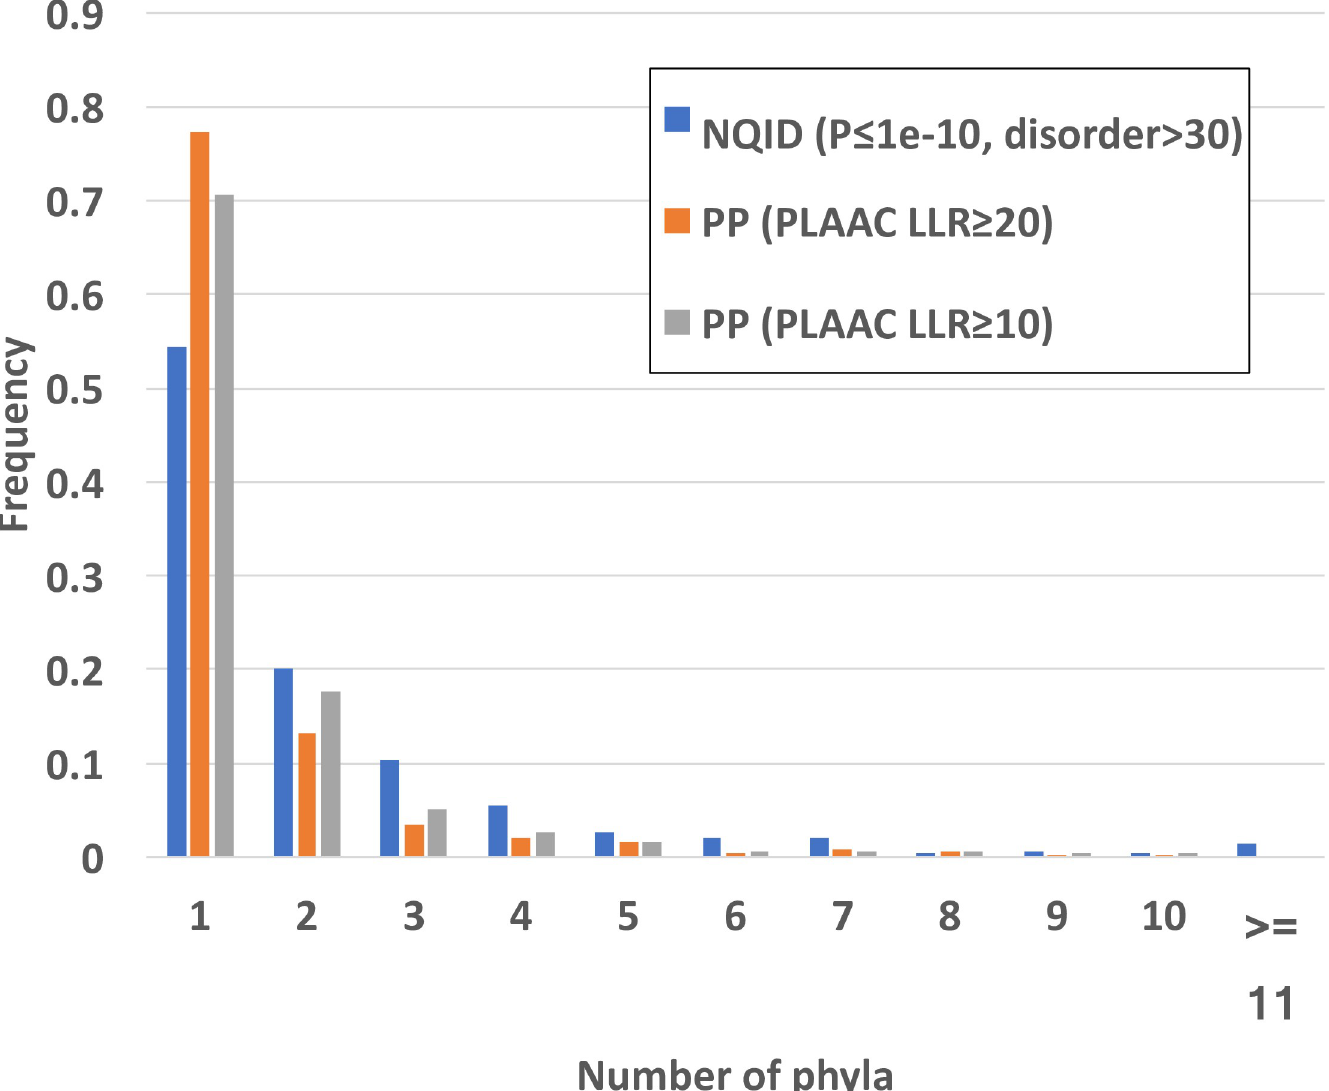
Fig 5. Cross-phylum distribution of prion-like protein families. The cross-phylum distribution of the prion-like protein family representative sequences is shown for prion prediction and NQID sets (as detailed in Methods ).